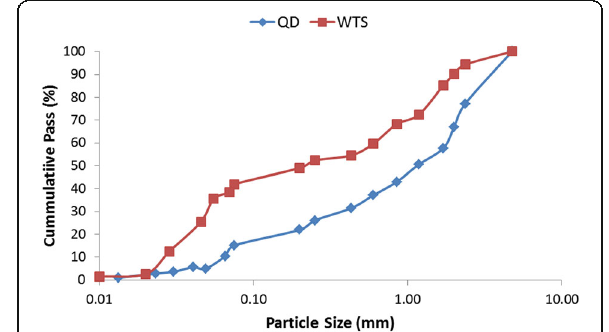
Fig. 3 Gradation of QD and